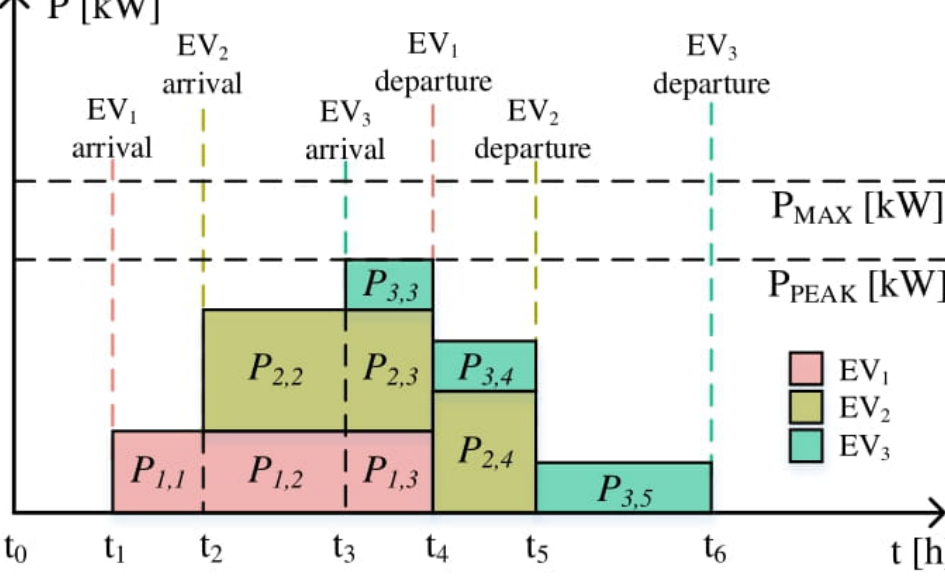
Figure 3. Notation for exemplary scenario.